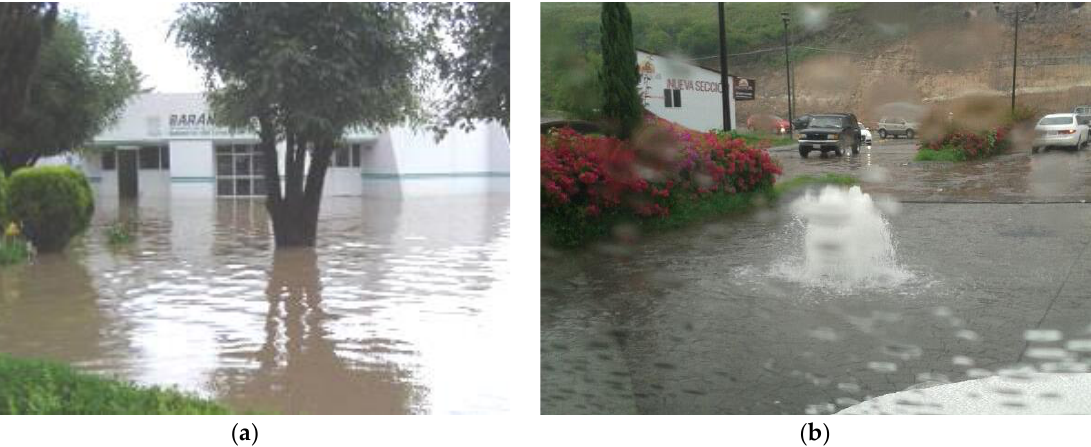
Figure 3. Evidence of extreme rainfall. ( a ) Urban flooding; ( b ) storm drainage working at pressure.